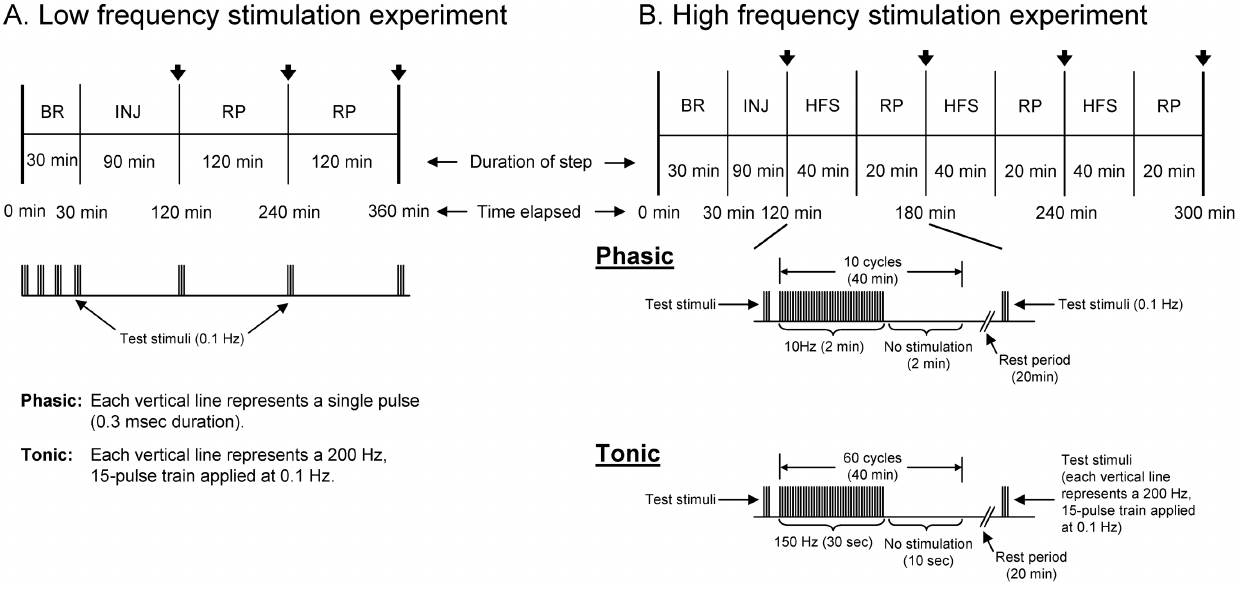
Figure 2. Timeline of the physiological recordings for neurotoxin injection experiments. A , Timeline of the low frequency stimulation experiment. B , Timeline of the high frequency stimulation experiment. In A and B , the black arrows ( ) mark the time when test stimuli (Phasic – three single pulses at 0.1 Hz; tonic – three, 200 Hz, 15- pulse trains at 0.1 Hz) were applied following injection, and below each timeline is a diagram depicting the stimulation protocol for phasic and tonic recordings (in B , an example of the high frequency stimulation (HFS) protocol is given from time elapsed mark of 120 min to 180 min). Baseline recording (BR): Phasic – three single pulses at 0.1 Hz every 10 min; tonic – three, 200 Hz, 15-pulse trains at 0.1 Hz every 10 min. High frequency stimulation (HFS): Phasic – burst stimuli of 10 Hz for 2 min with an inter-burst interval of 2 min; tonic – burst stimuli of 150 Hz for 30 sec with an inter-burst interval of 10 sec. INJ – injection, RP – rest period.